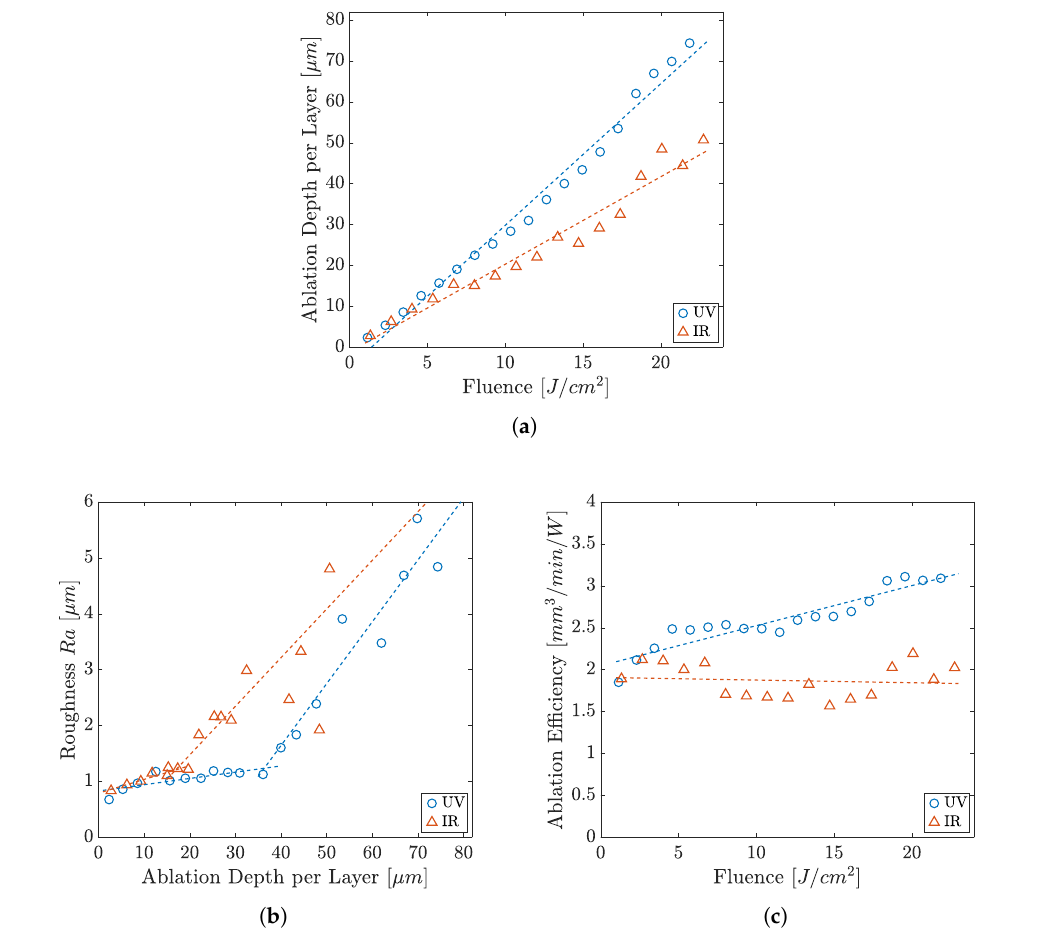
Figure 9. Comparison of the ablation values of COC of the different wavelengths UV and IR under same conditions: ( a ) ablation ( b ) roughness ( c ) ablation